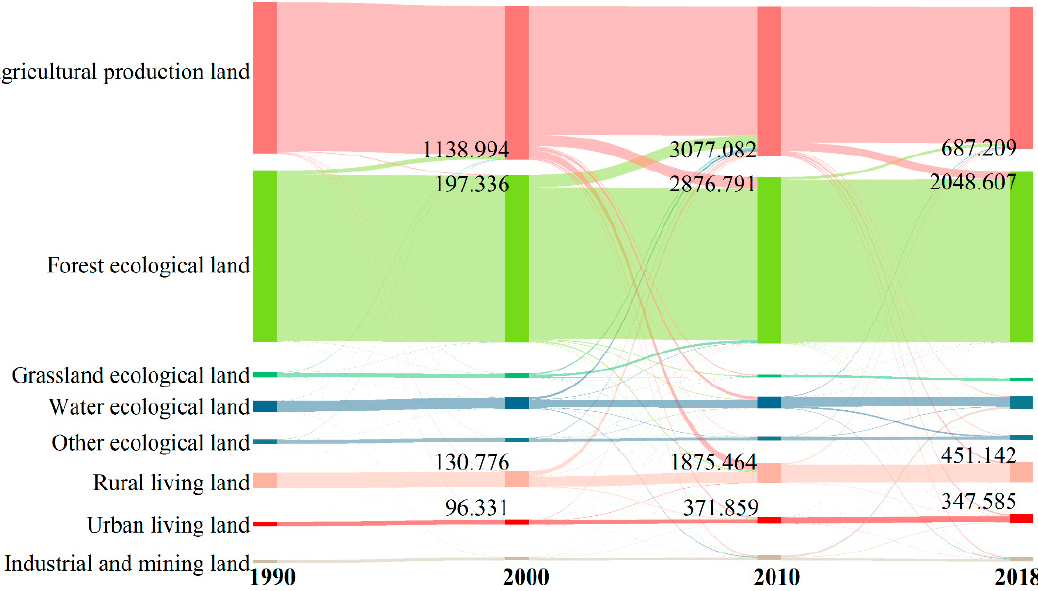
Figure 3. Sankey diagram of land-use transitions in the central and southern Liaoning urban agglom- eration 1990–2018.